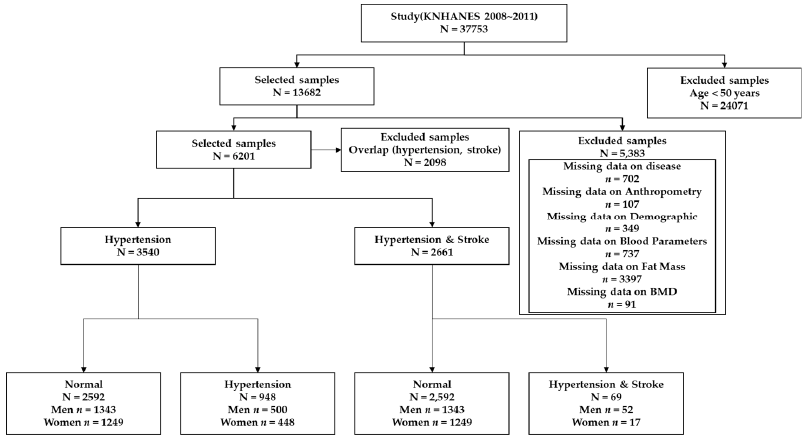
Figure 2. Sample selection procedure. BMD, bone mineral density.